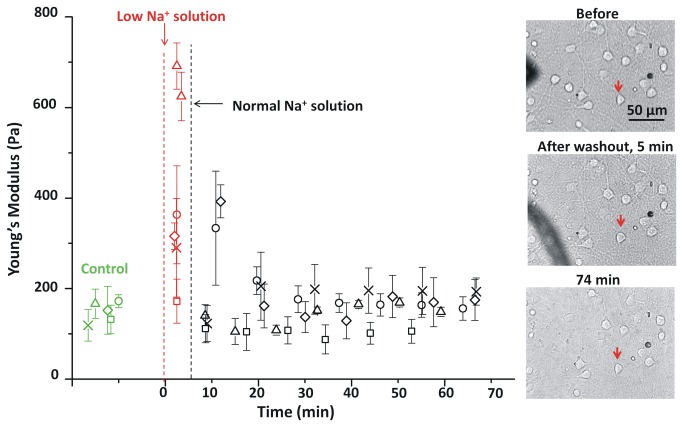
Elasticity changes in response to a brief hypotonic shock.The Young’s modulus for five neurons (each with a different symbol) are plotted before (green), during (red) and after (black) treatment with low Na+ BPS (70 mM, 217 mosM). The low Na+ BPS was replaced with BPS solution at 5 min (cross, diamond, square and circle symbols), and 7 min (triangles). Images show the morphology of the soma for one experiment (diamonds, neuron studied is marked with a red arrow) before and at two times after hypotonic shock. Error bars are standard deviations for each neuron soma.